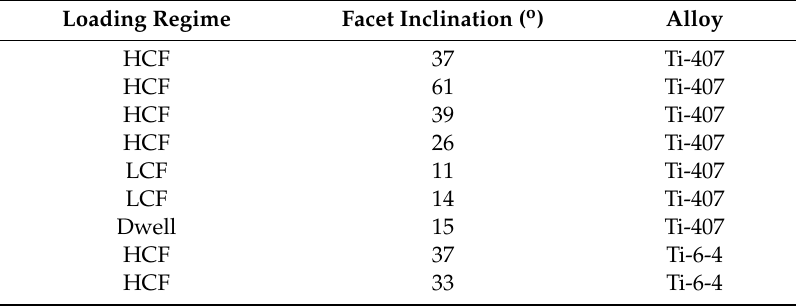
Table 1. QTF measurements of fatigue initiating